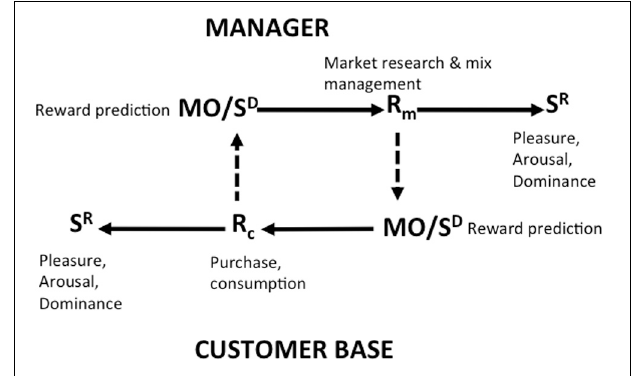
FIGURE 8 | Bilateral contingency between the marketing firm and its consumerate in terms of reward prediction